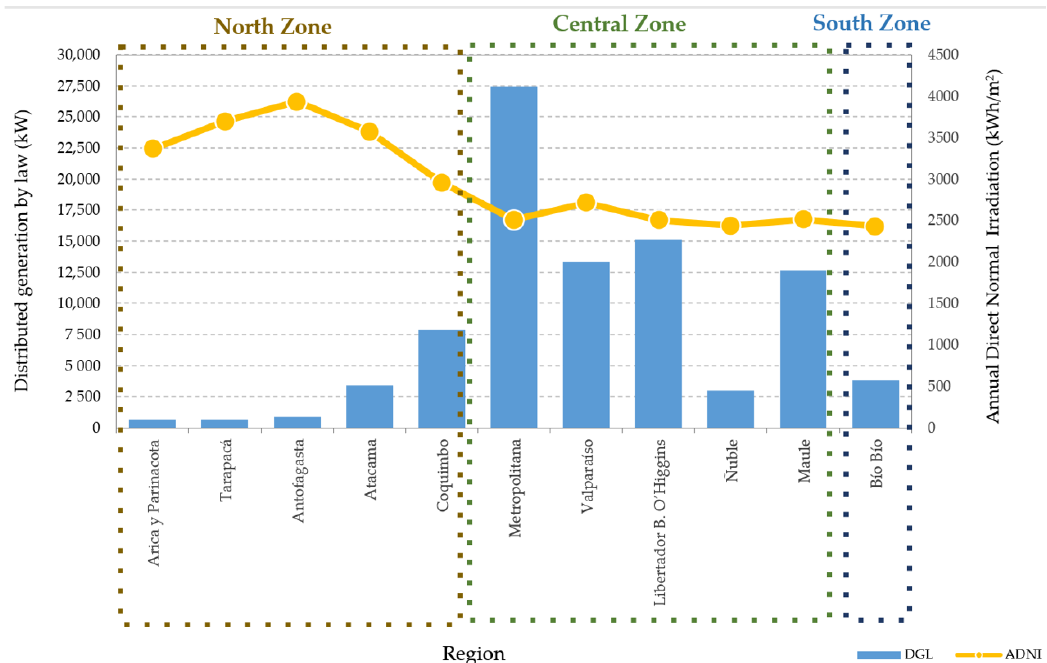
Figure 7. Comparative graph of Ley de Generación Distribuida and Annual Normal Irradiation by region. Prepared by the authors.